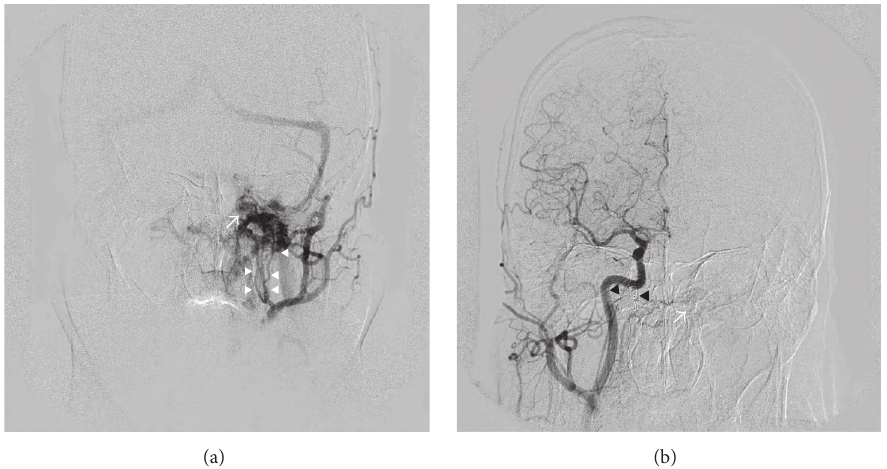
Figure 2: (a) Left external carotid angiogram demonstrates dural arteriovenous fistula around left jugular valve. Dural arteriovenous fistula is mainly fed by meningeal branches of the left ascending pharyngeal artery (arrowhead) and drained to left internal jugular vein, bilateral vertebral venous plexus through the left anterior condylar vein. Left cavernous sinus and transverse-sigmoid sinus are refluxed. Anterior condylar confluence is depicted as expanded venous pouch (arrow). (b) Right common carotid angiogram demonstrated obliteration of dural arteriovenous fistula in the right anterior condyle confluence. Coil mass inserted five years ago is depicted (arrowhead). Right ascending pharyngeal artery feeds dural arteriovenous fistula in the contralateral anterior condylar